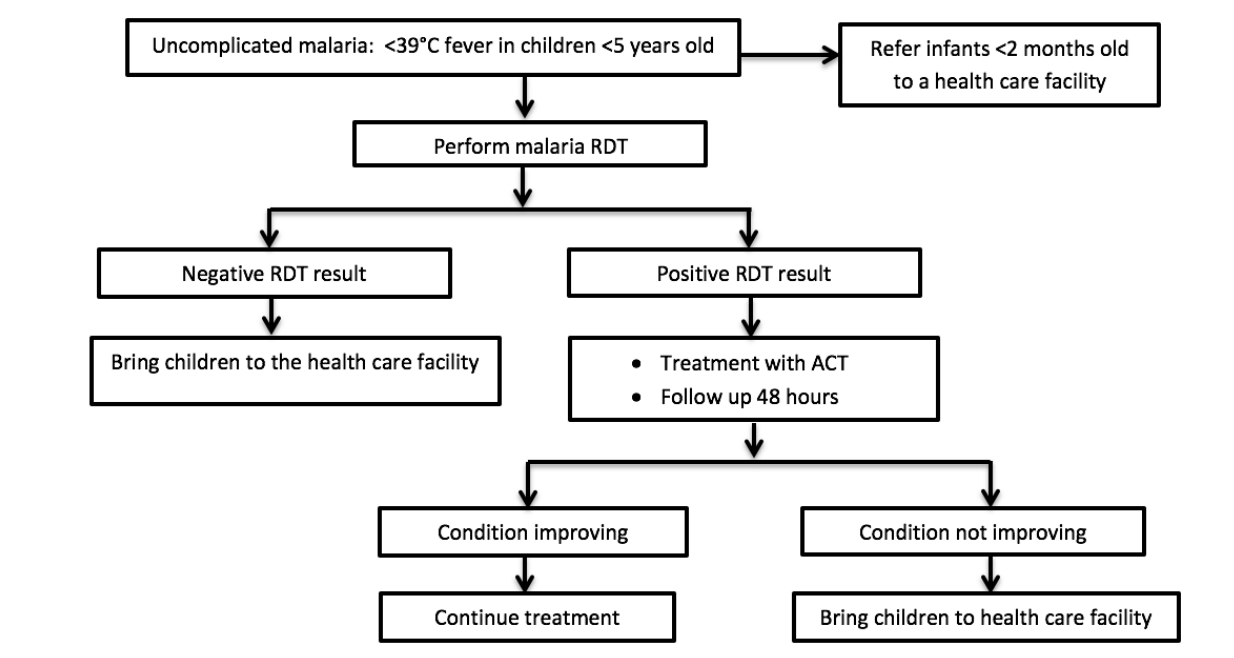
Figure 3. Algorithm for the home management of malaria adapted from that used in Senegal. ACT: artemisinin-based combination therapy; RDT: rapid diagnosis